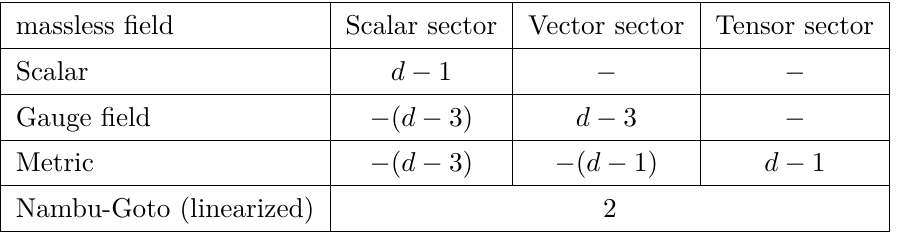
Table 1 . Values of M obtained for linearized perturbations of various fields of interest in Schwarzschild-AdS background. Note that both positive and negative values of M are thus ob- d +1